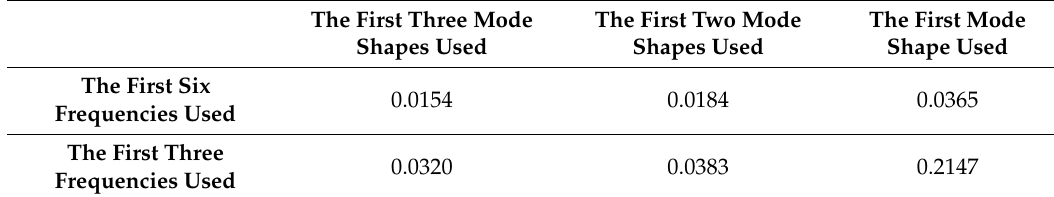
Table 8. Maximum difference between the identified damage factor and the theoretical value in the improved method using different modes.